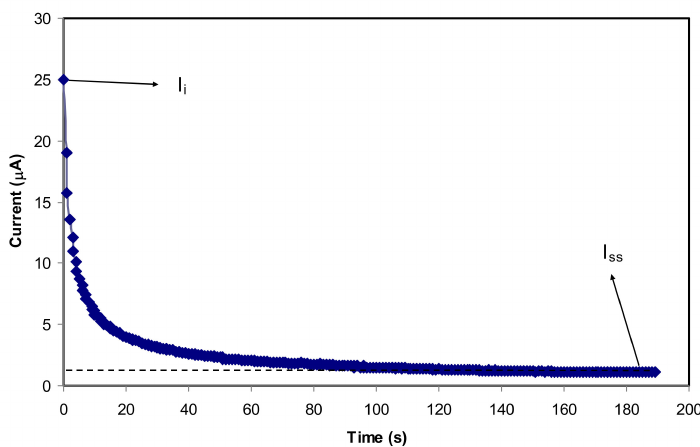
Figure 6. Current versus time for the highest conducting